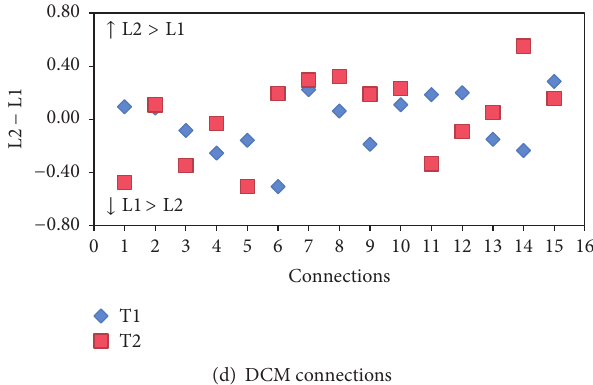
Figure 5: Patient 3. (a) The T1-weighted MRI image at T1 shows a hemorrhagic stroke in the left basal ganglia. (b) Pattern of brain activation in different conditions while picture naming, with an uncorrected 𝑝 < 0.001 for the main effects. (c) Behavioral results of the combined production scores in both languages, linguistic and nonlinguistic switching scores across sessions. ∗ represents 𝑝 value < 0.05 and ∗∗ represents 𝑝 value < 0.001. (d) Differences between L1 strength values and L2 strength values for each single connection across sessions. (1) ACC to LIFGTri. (2) ACC to LIFGOrb. (3) ACC to LC. (4) LC to ACC. (5) LC to LIFGTri. (6) LC to LIFGOrb. (7) LIFGTri to LC. (8) LIFGTri to ACC. (9) LIFGOrb to LC. (10) LIFGOrb to ACC. (11) LIFGTri to LIFGOrb. (12) LIFGOrb to LIFGTri. (13) BTLA to LIFGTri. (14) BTLA to LIFGOrb. (15) BTLA to LC.